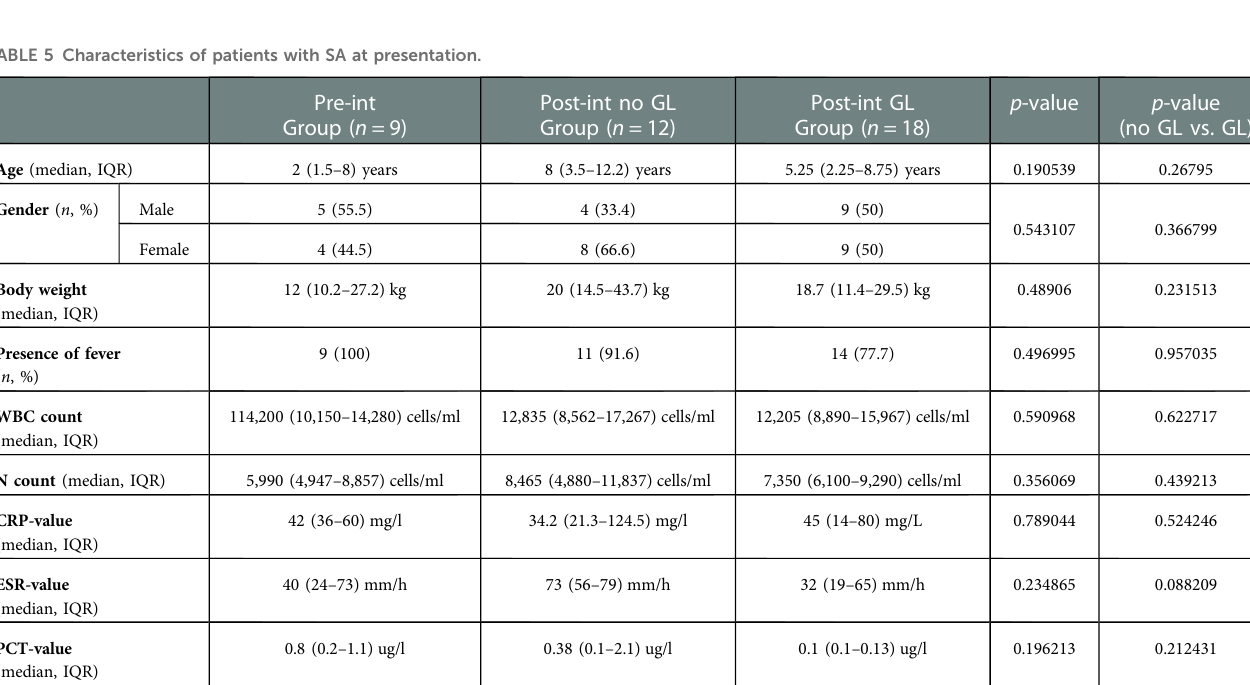
( p = 0.94). The rate of children discharged with integrated home care was lower in the post-intervention groups ( p ≤ 0.05). LOT, DOT and bsDOT/DOT were lowest in the GL group, but not signi fi cantly. No statistically signi fi cant differences were found for treatment failure, including surgery. There was no relapse at six months. After comparison of no GL and GL groups, LOS, IV DOT, DOT, DOT/LOT ratio, bsDOT and bsDOT/DOT ratio resulted signi fi cantly inferior in the GL group ( Table 8 ).